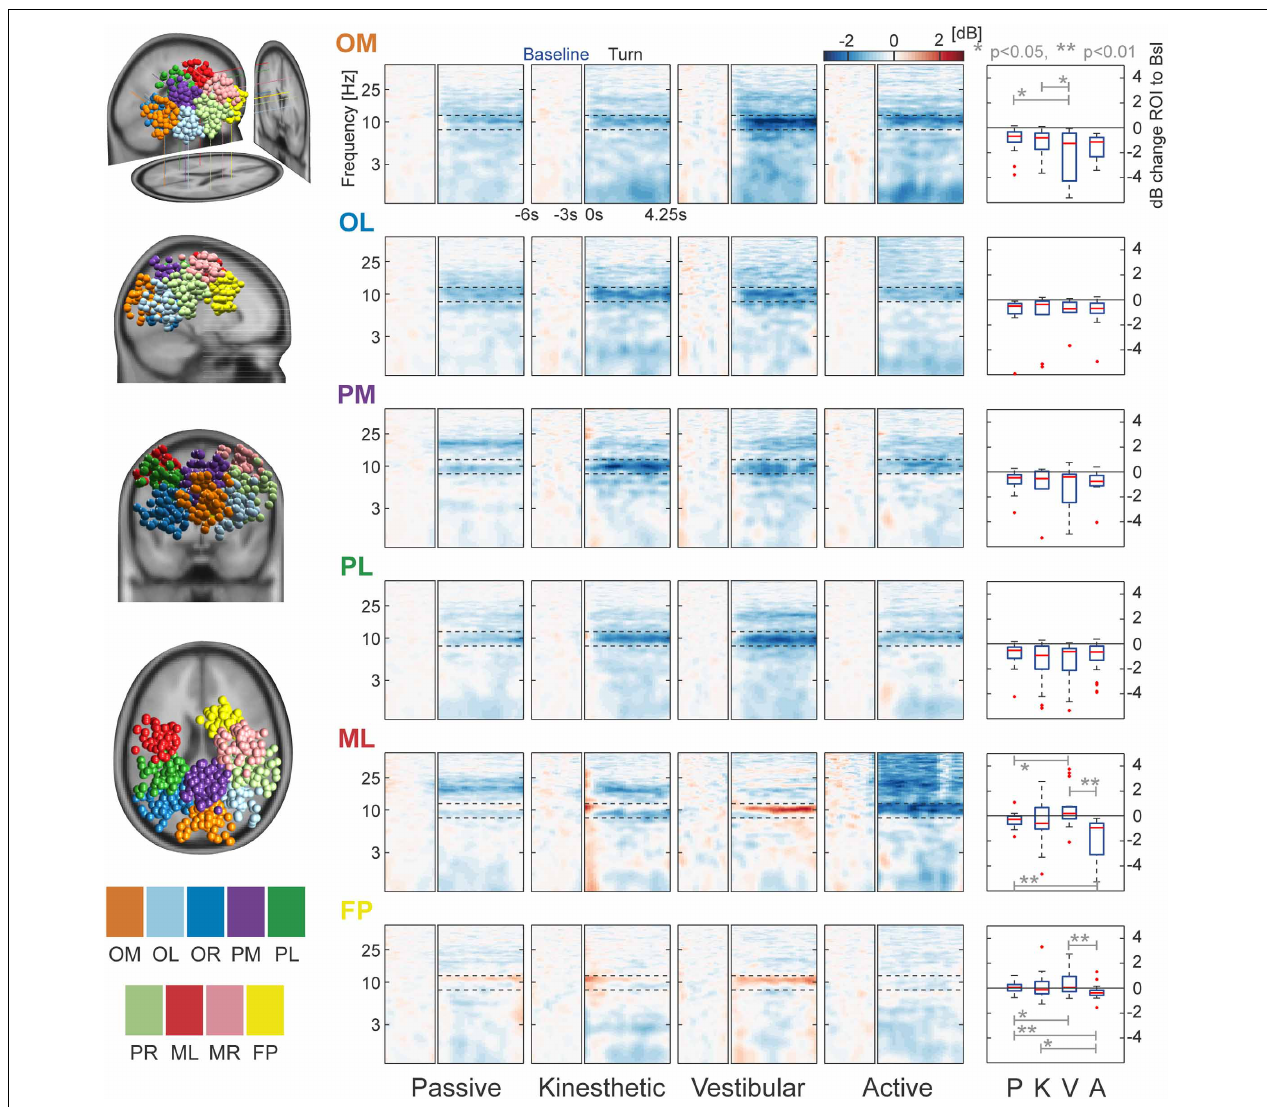
FIGURE 5 | Clusters and task-related alpha modulations. The left column displays the locations of all dipoles belonging to the nine separate clusters projected to an MNI standard brain. Log-frequency ERSPs are shown in the central four columns. Blue denotes a decrease and red an increase in EEG power compared with baseline. ERSPs are not shown for PR, MR, and OR—they strongly resemble the pattern of their contralateral equivalents PL, ML, and OL. Boxplots in the right column depict the mean, cluster-wise ERSP activity in the alpha band (8–12Hz) during the turn for each condition. In